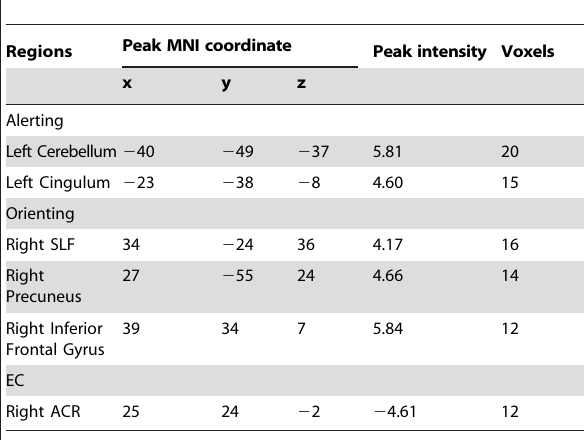
Table 3. FA skeleton regions for the correlations between attentional performances and FA skeleton